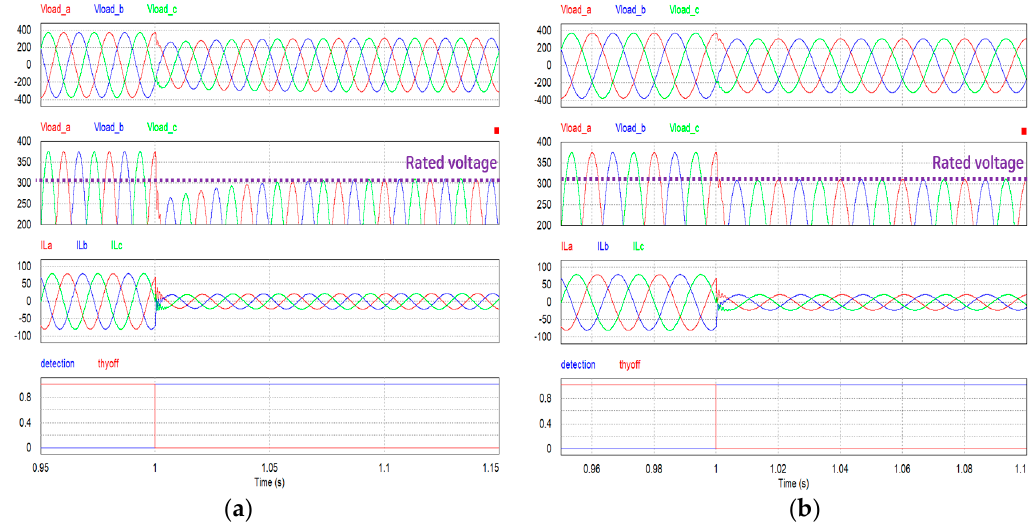
Figure 13. Simulation results of mode switching in the case of high-grid voltage during renewable energy generation: ( a ) using the general inverter controller; ( b ) using the proposed load current compensation controller.